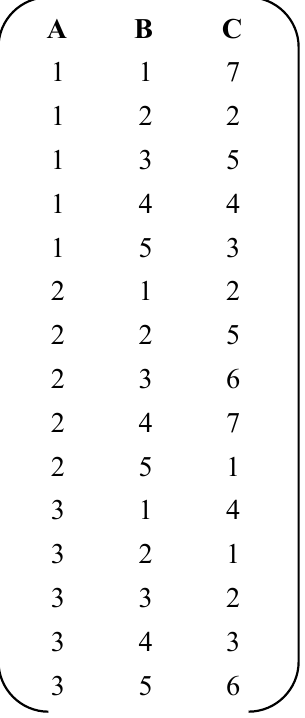
Table 1. Model matrix for EA (15, 3 1 5 1 7 1 ).